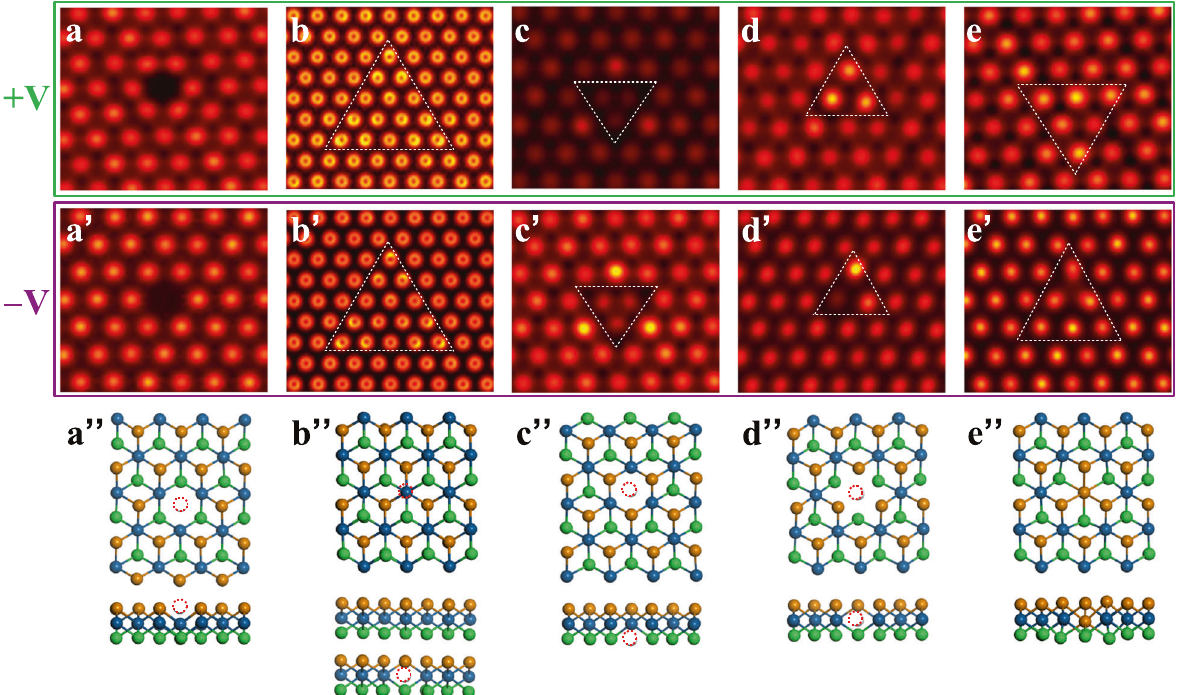
Fig. 6 DFT-STM images of the fi ve types of defects A – E identi fi ed. Images ( a – e ) at positive bias, and images ( a ′ – e ′ ) at negative bias conditions. Figures ( a ″ – e ″ ) the top view and side view of the associated relaxed structures, illustrating the defect in each structure. Red dashed circle represents a